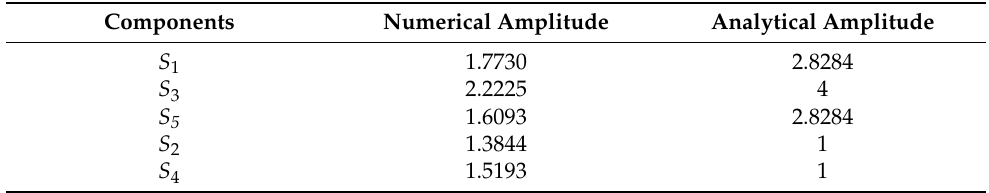
Table 1. Maxima of numerical and analytical results with a starting time of t 1,0 = − 3. (Amplitude S n as solutions of Equation